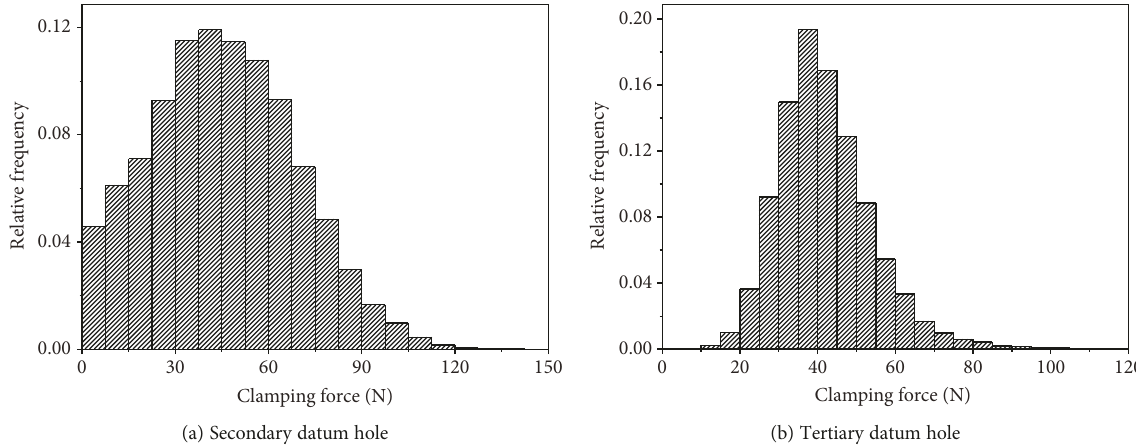
Figure 8: Distributions of magnitude of clamping forces at nonprincipal datum hole